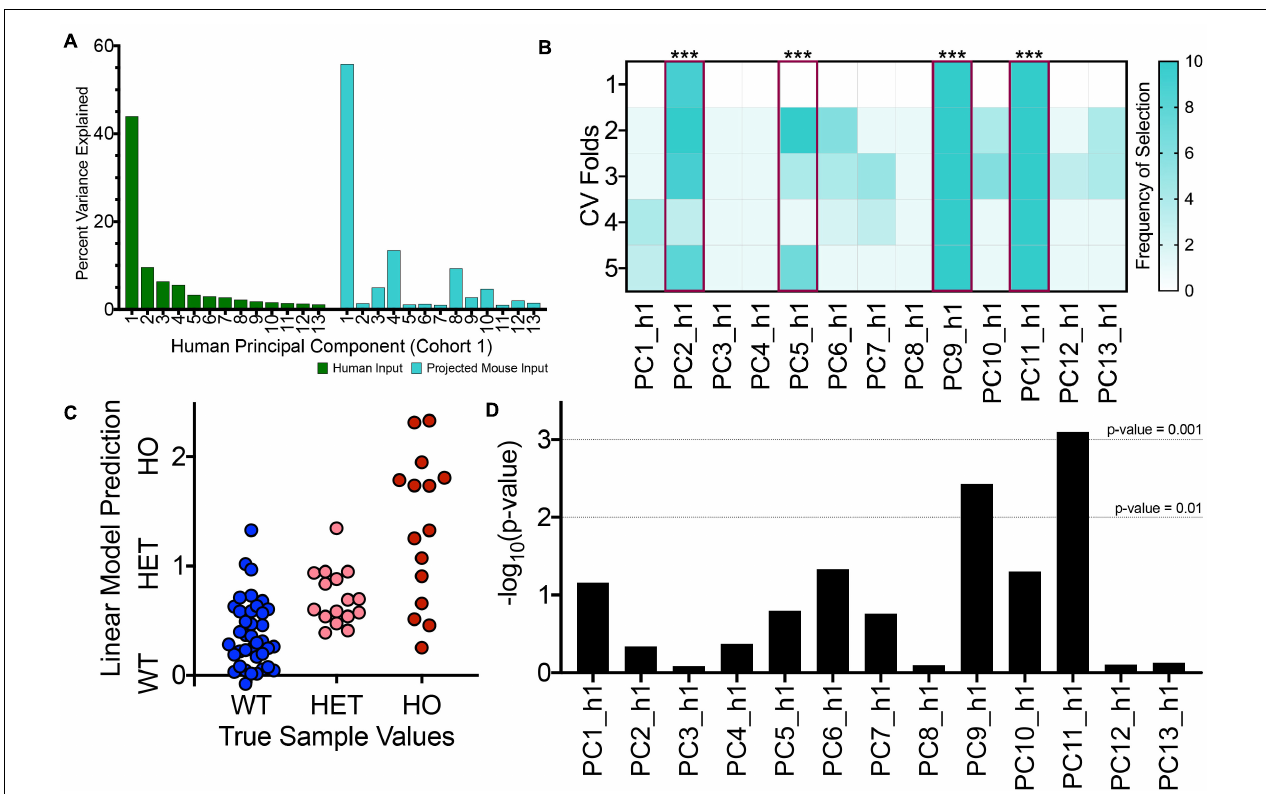
FIGURE 3 | TransComp-R modeling successfully identifies translatable, human principal components that are important for TASTPM mouse outcomes. (A) Percent variance explained by each human PC for the original human dataset used to generate the PCA model (GSE48350, cohort 1; green) and the projected mouse dataset (turquoise). (B) Frequency of human PC (PC_h1) selection across ten rounds of 5-fold cross validation (CV) using LASSO feature selection based on mouse sample outcome. Human PCs that satisfied the 40 percent selection frequency threshold are highlighted in magenta with the significance of the linear regression model weights provided (*** < 0.001). (C) Visualizing linear model predictions on a mouse sample-by-sample basis from the final linear model with four PC inputs across the wild type (WT), heterozygous TASTPM (HET), and homozygous TASTPM (HO) groups. (D) Results from linear modeling evaluating which PCs